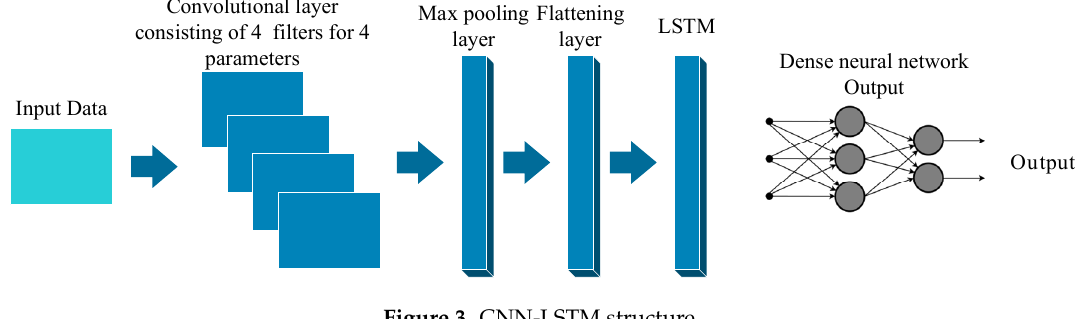
Figure 3. CNN-LSTM structure.